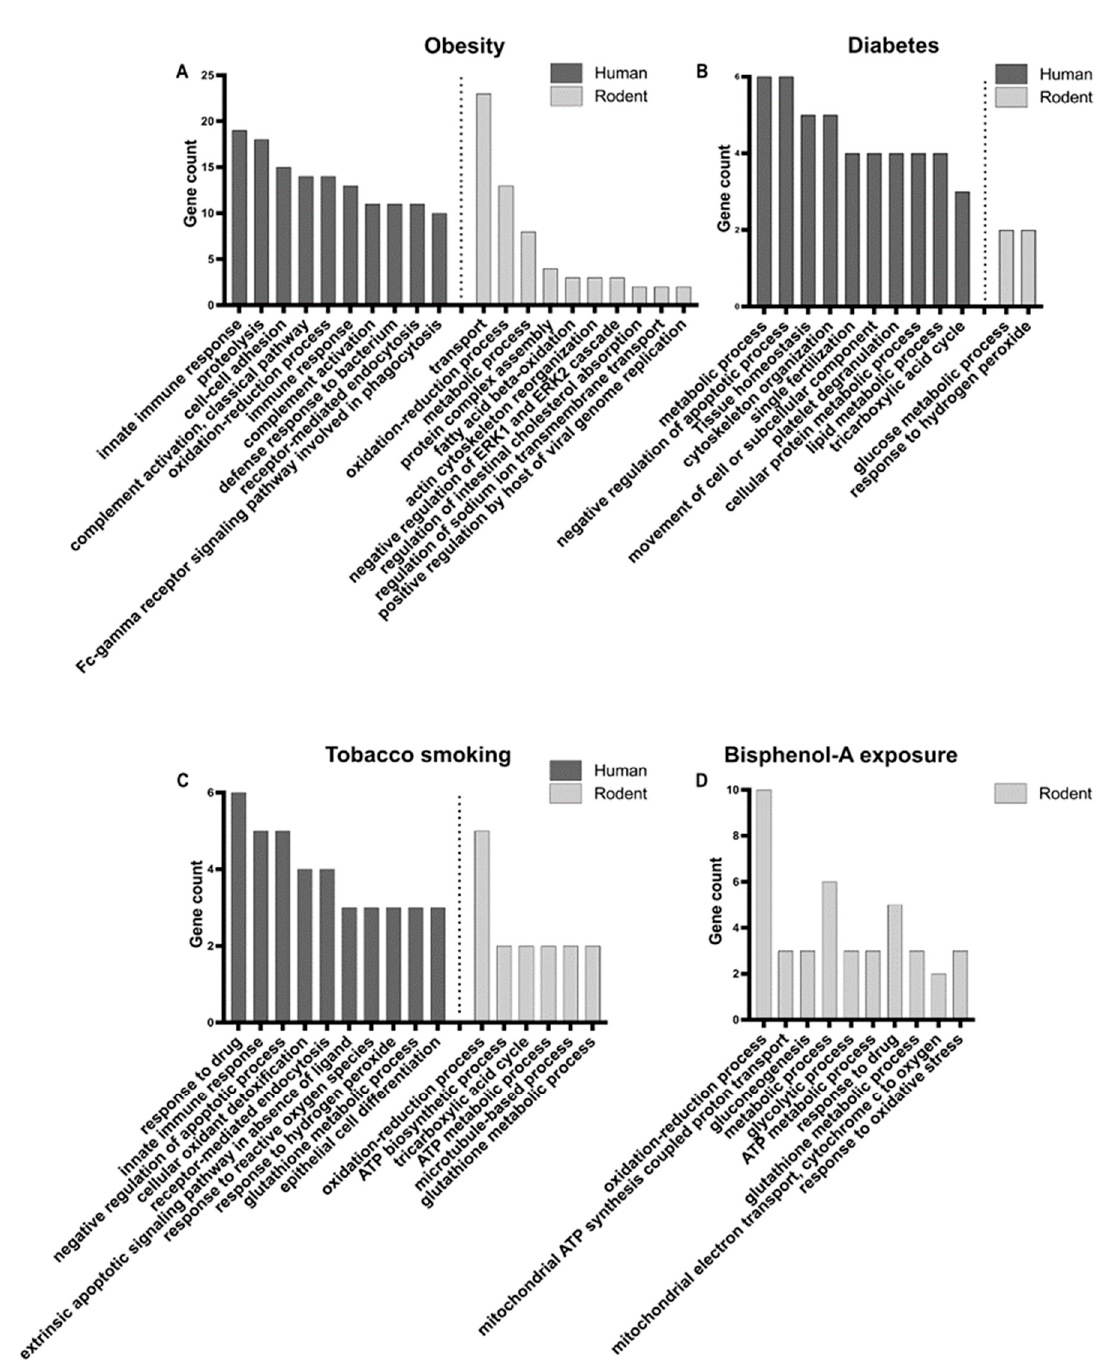
Figure 2. Enriched GO biological processes for deregulated sperm proteins in human and rodent models in relation to obesity ( A ), diabetes ( B ), tobacco smoking ( C ), and bisphenol-A (BPA) exposure ( D ). Top 10 enriched processes are presented. For BPA, only the protein list from mice was submitted to GO analysis. See Table S3 for complete dataset.